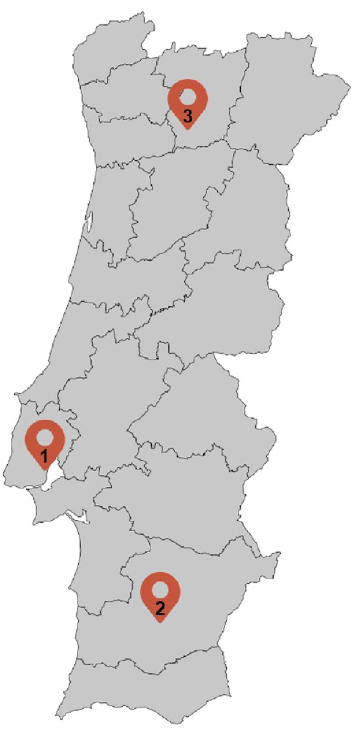
Fig. 7 Portugal’s map: 1—Santa Iria de Azoia; 2—Castro Verde; 3— Vila